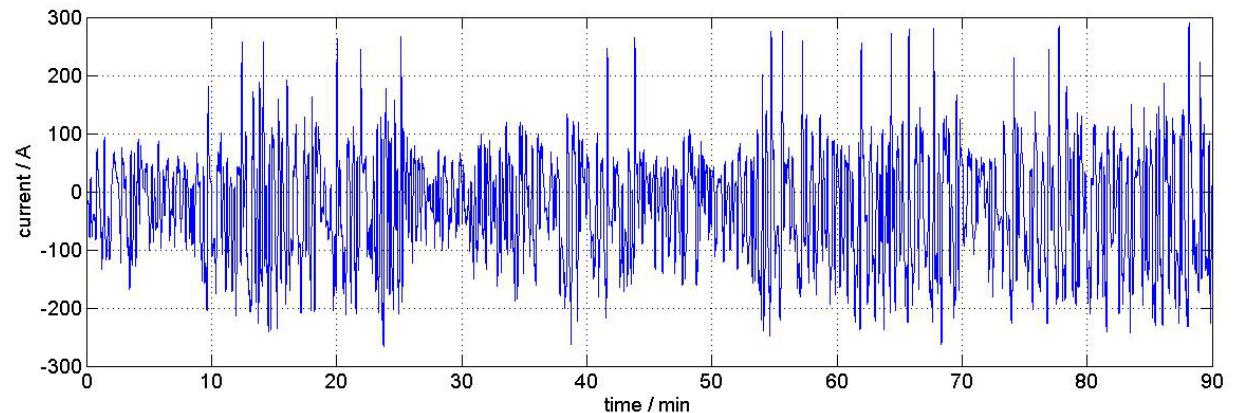
Figure 10. Current profile applied to the cyclically-degraded cell.